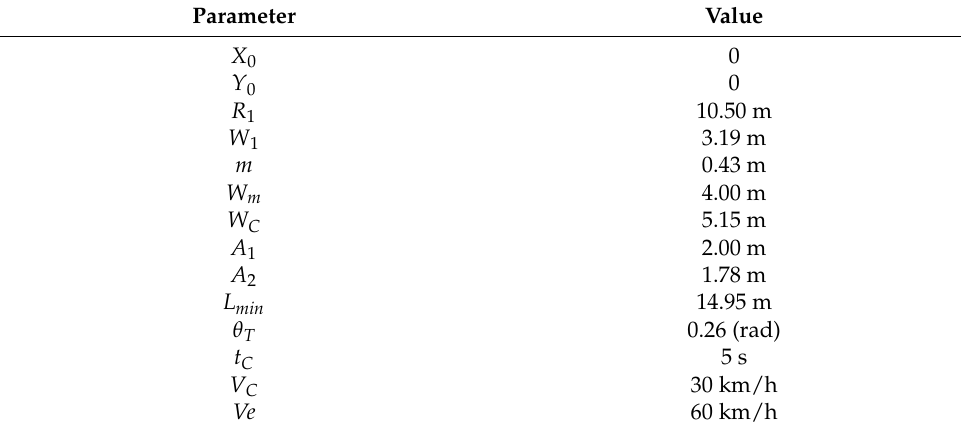
Table 1. Input data used for validation.